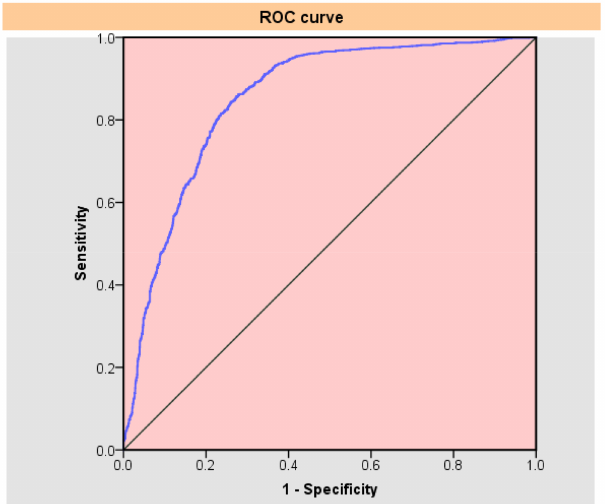
Figure 2. Forecast accuracy of the BP neural network